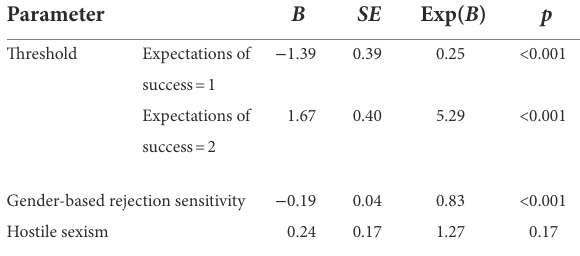
TABLE 1 Summary of OLR model on women’s gender-related relative expectations of success. Parameter